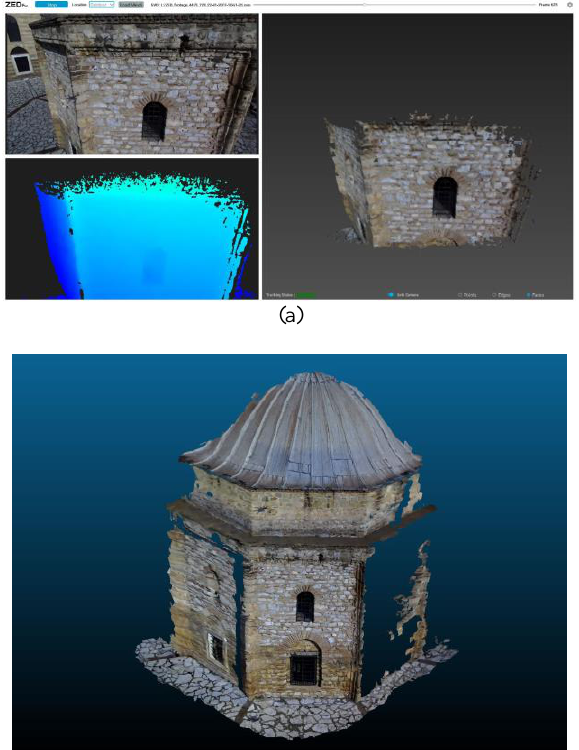
Figure 6. (a) SLAM reconstruction of .svo files in ZED Fu (b) mesh output of one .svo file.